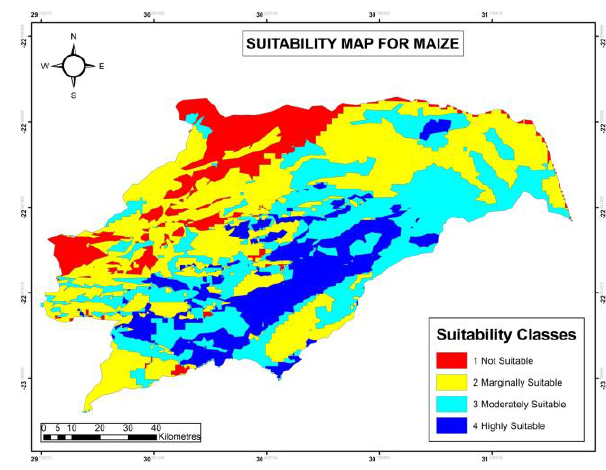
Figure 6. Suitability map for maize; Source: Authors (2020)